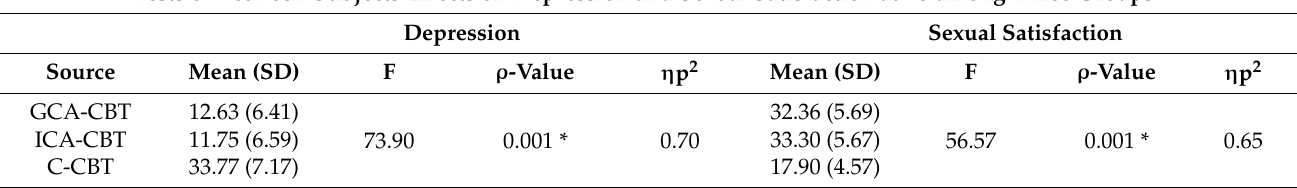
Table 4. One-Way ANOVA for GCA-CBT, ICA-CBT, and C-CBT at follow-up. Tests of Between-Subjects Effects on Depression and Sexual Satisfaction at T3 among Three